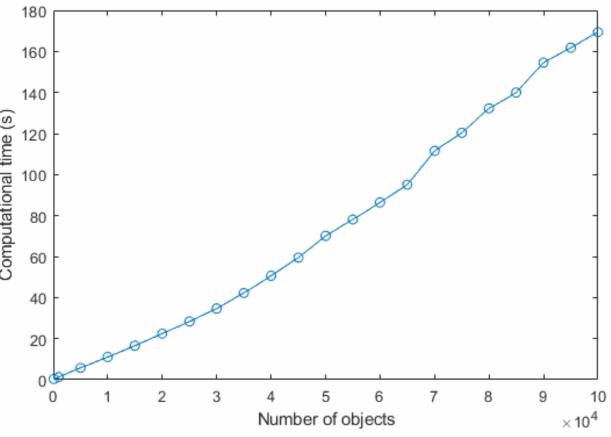
Figure 14. The computational time of the proposed algorithm in terms of the number of